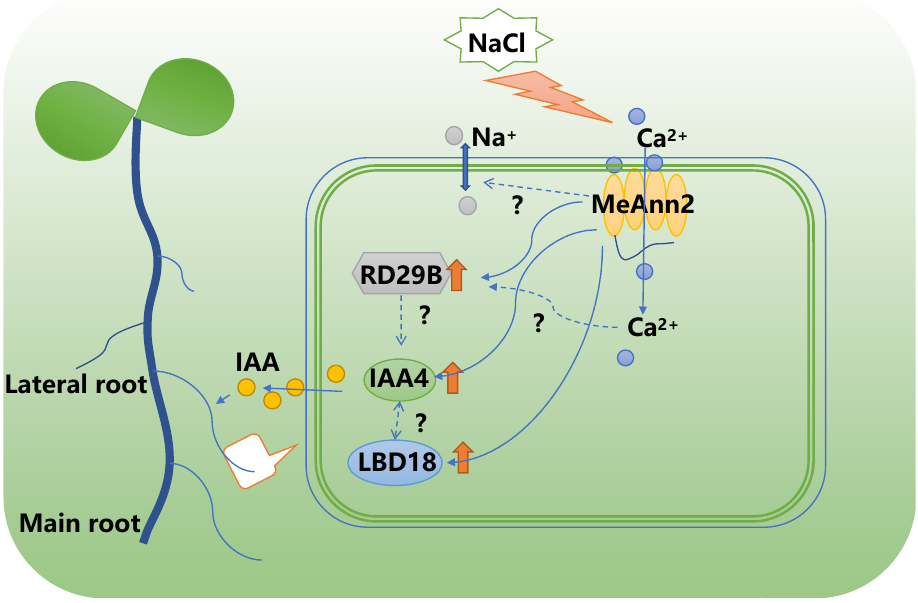
Figure 8. Predicated mechanism of MeAnn2 in improved plant salt tolerance. The orange arrows indicate the gene up-regulated. The question marks indicate the unknown mechanism.